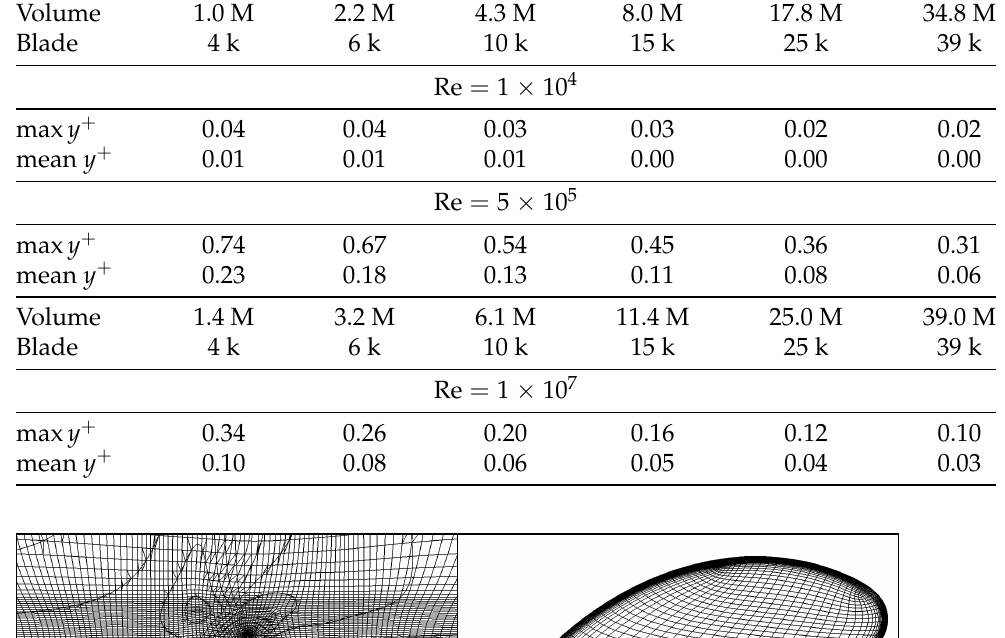
Table 3. Overview of the grid sizes and number of cell faces on a single blade. Maximum and mean y + at Re = 1 × 10 4 , 5 × 10 5 and 1 × 10 7 . M and k denote million and thousand, respectively.